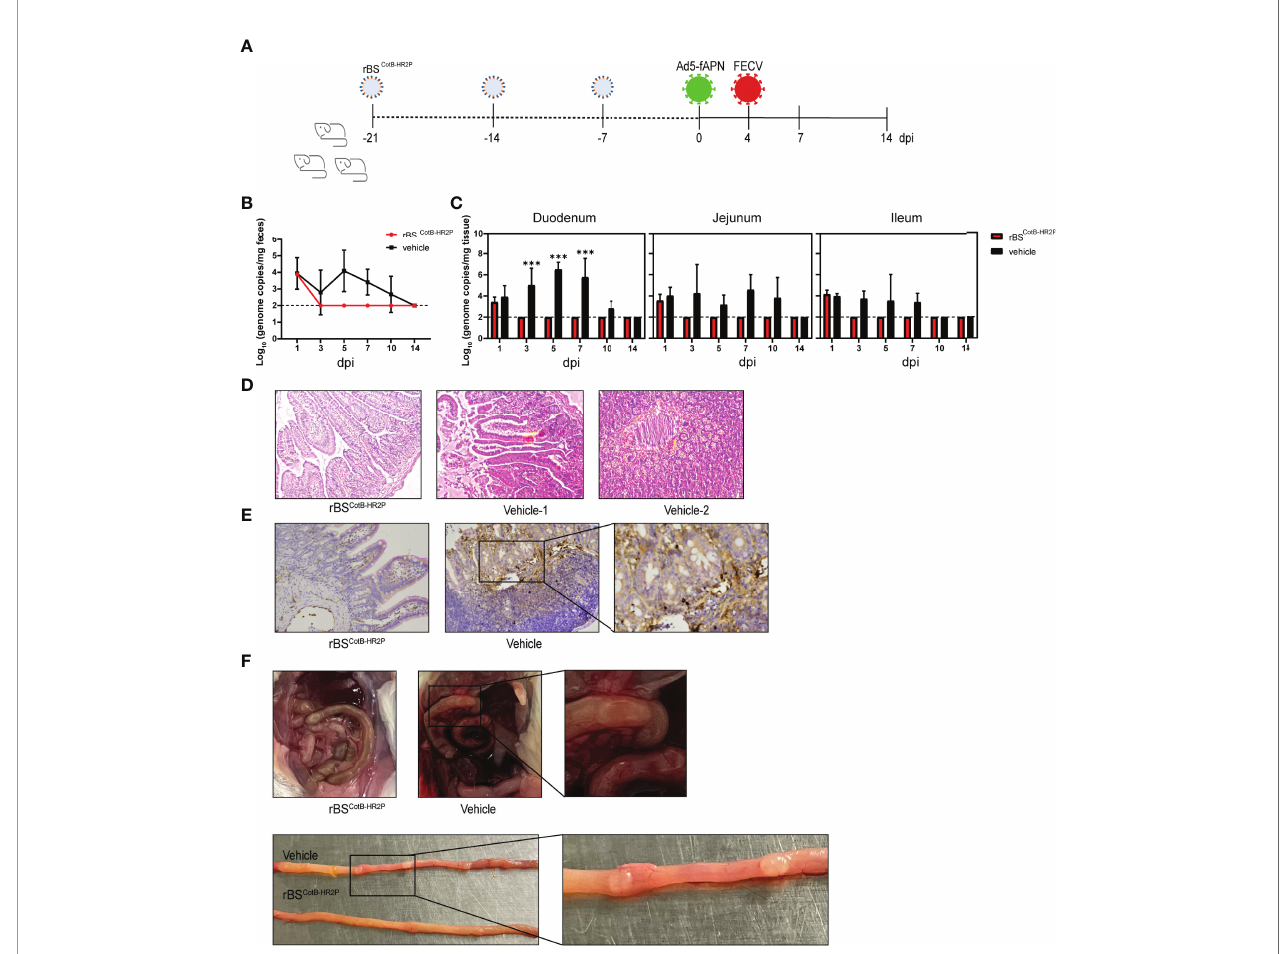
FIGURE 5 | Immunization with rBS CotB-HR2P protected mice against FECV infection. (A) Mice were inoculated with either rBS CotB-HR2P or PBS (Ctrl) by gavage on days 1 – 3, 8 – 10, and 15 – 17. In order to make the mice susceptible to FECV infection, each was injected intraperitoneally (i.p.) with 2.5 × 10 6 TCID 50 Ad5-fAPN/Ad5-GFP, and 4 d later, each was i.p. challenged with 10 5 TCID 50 of FECV. (B) Viral RNA in feces was quanti fi ed by qPCR; n = 3 mouse in each group at 1, 3, 5, 7, 10, and 14 dpi. (C) FECV RNA load in the duodenum, jejunum, and ileum was determined at 1, 3, 5, 7, 10, and 14 dpi by qPCR; n = 3 mice per group. (D) Representative hematoxylin/ eosin-stained section of mouse intestine. (E) IHC staining of the intestine for FECV N protein, showing viral replication. (F) Representative gross pathologic lesions found in the small intestine (intestinal granulomatous lesions in the duodenum). *** P